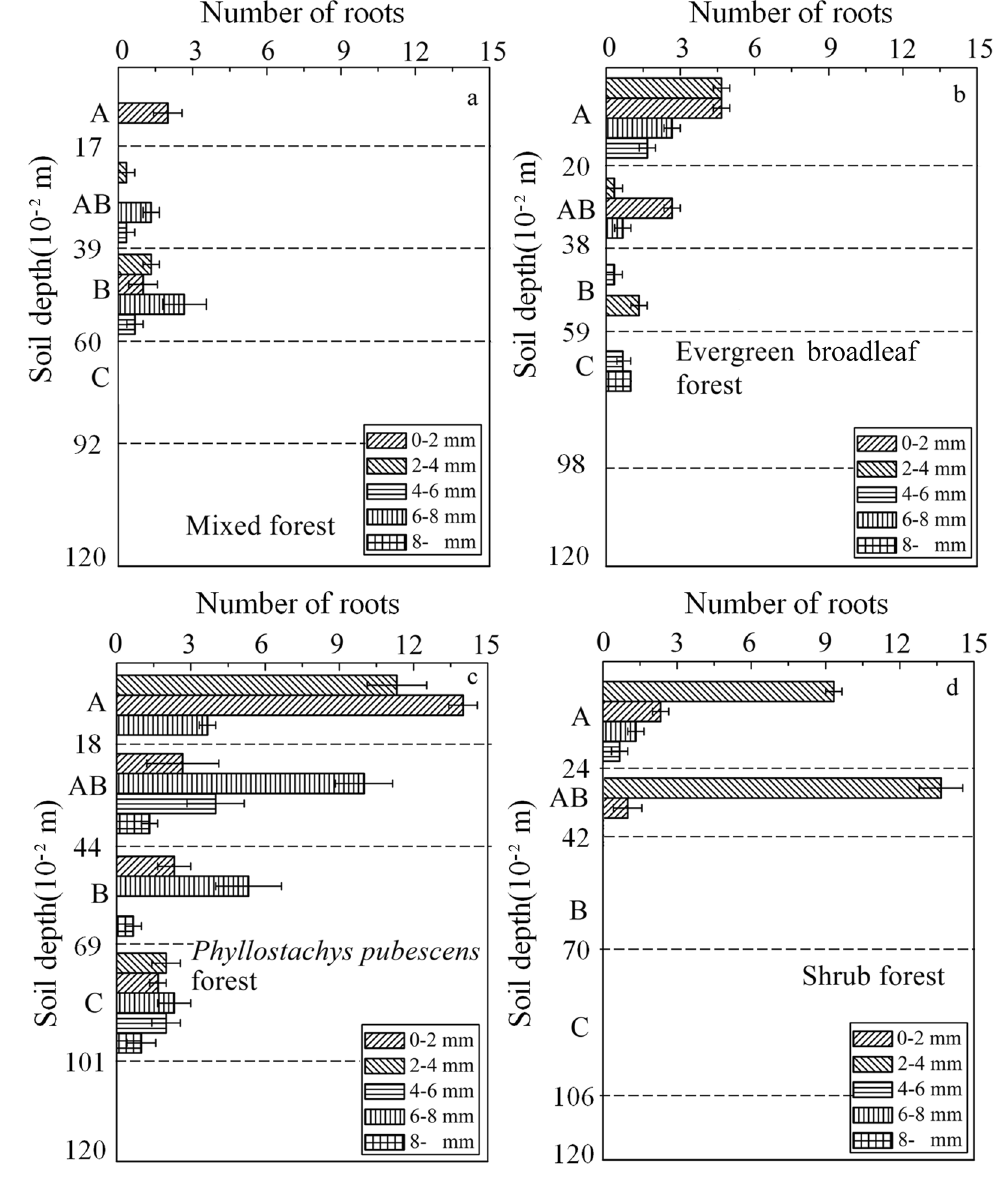
Figure 1. Comparisons between number of roots and root diameter-class of soil layers from 4 stands. Error bars indicate the standard deviation (SD) of each